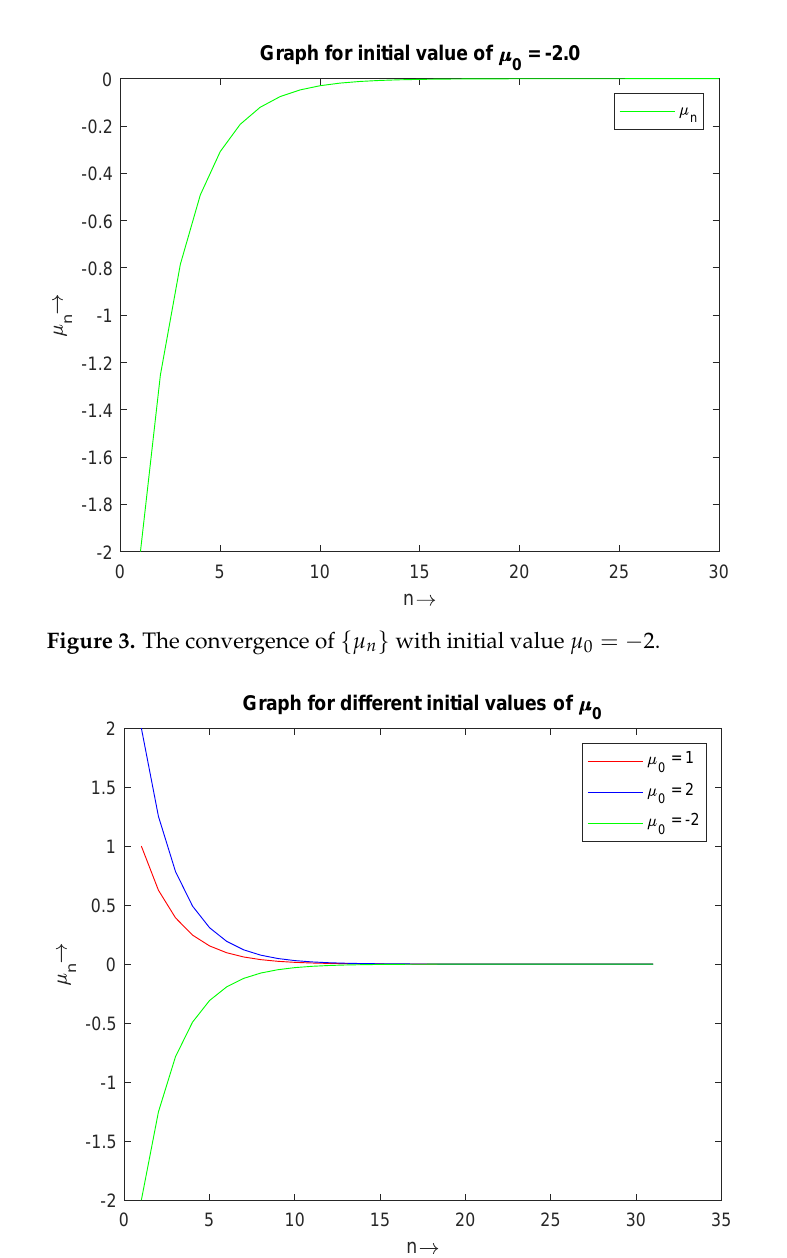
Figure 4. The convergence of { µ n } with initial values µ 0 = 1, µ 0 = 2 and µ 0 = −